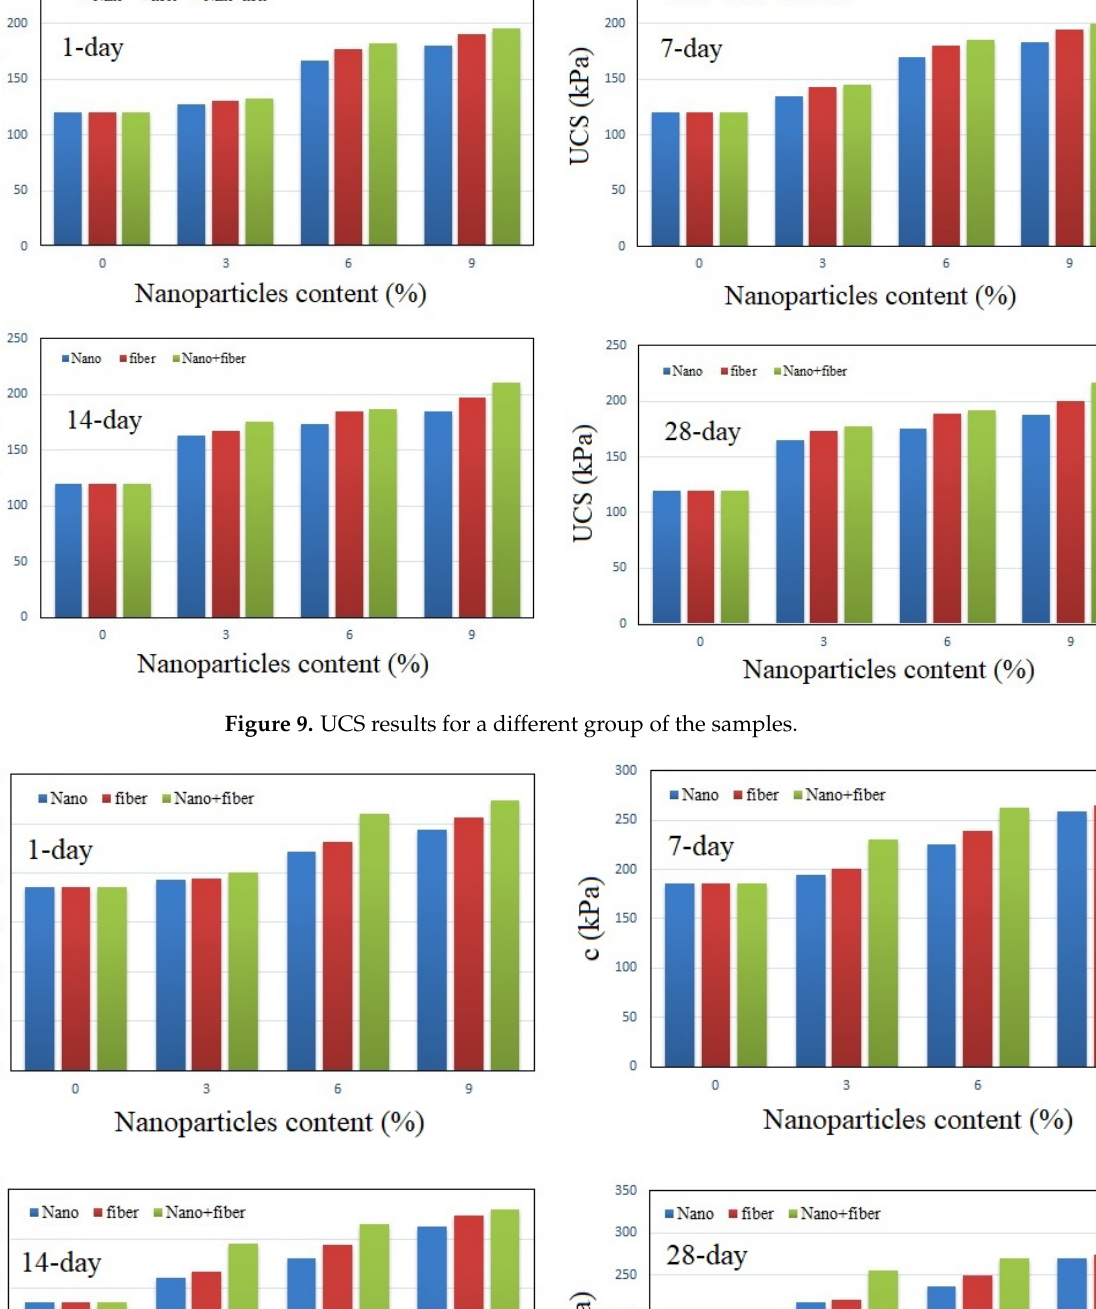
Figure 11. Estimated friction for a different group of samples.